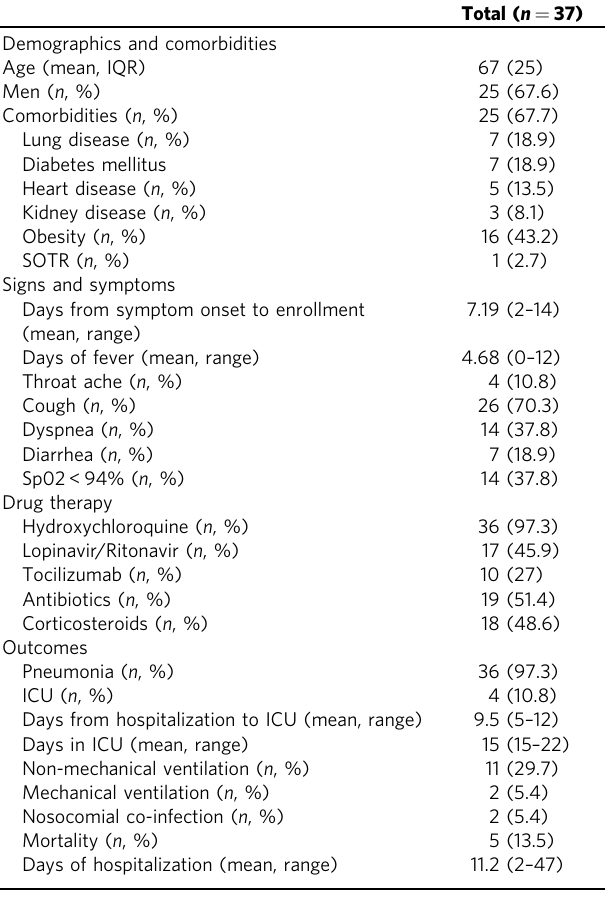
Table 1 Demographics and clinical characteristics of the BACO